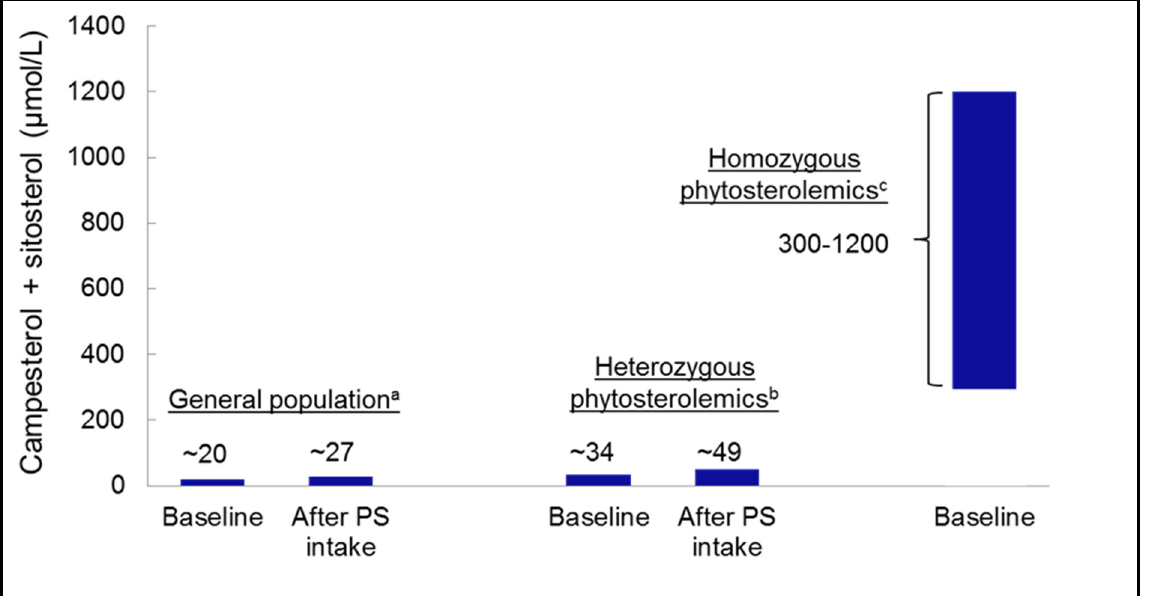
Figure 3. Plasma concentrations (baseline and after phytosterol (PS) intake) of campesterol and sitosterol in the general population and in individuals heterozygous for phytosterolemia versus in patients homozygous for phytosterolemia. a based on data from 41 human intervention studies [128]. b based on four studies regarding individuals with heterozygous phytosterolemia [18,61,62,129]. c based on cases with homozygous phytosterolemia [20,21].